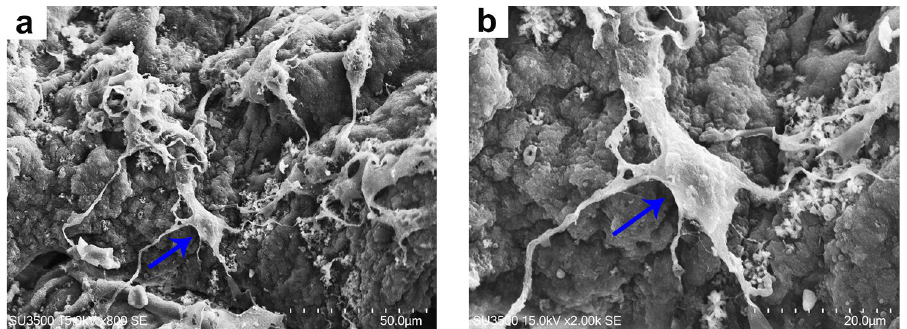
Figure 7. ( a ) The attachment of OLN-93 neural cells on nanochitosan/PPy–Alg scaffold. ( b ) High magnitude illustration of the cell which shows by blue arrow.